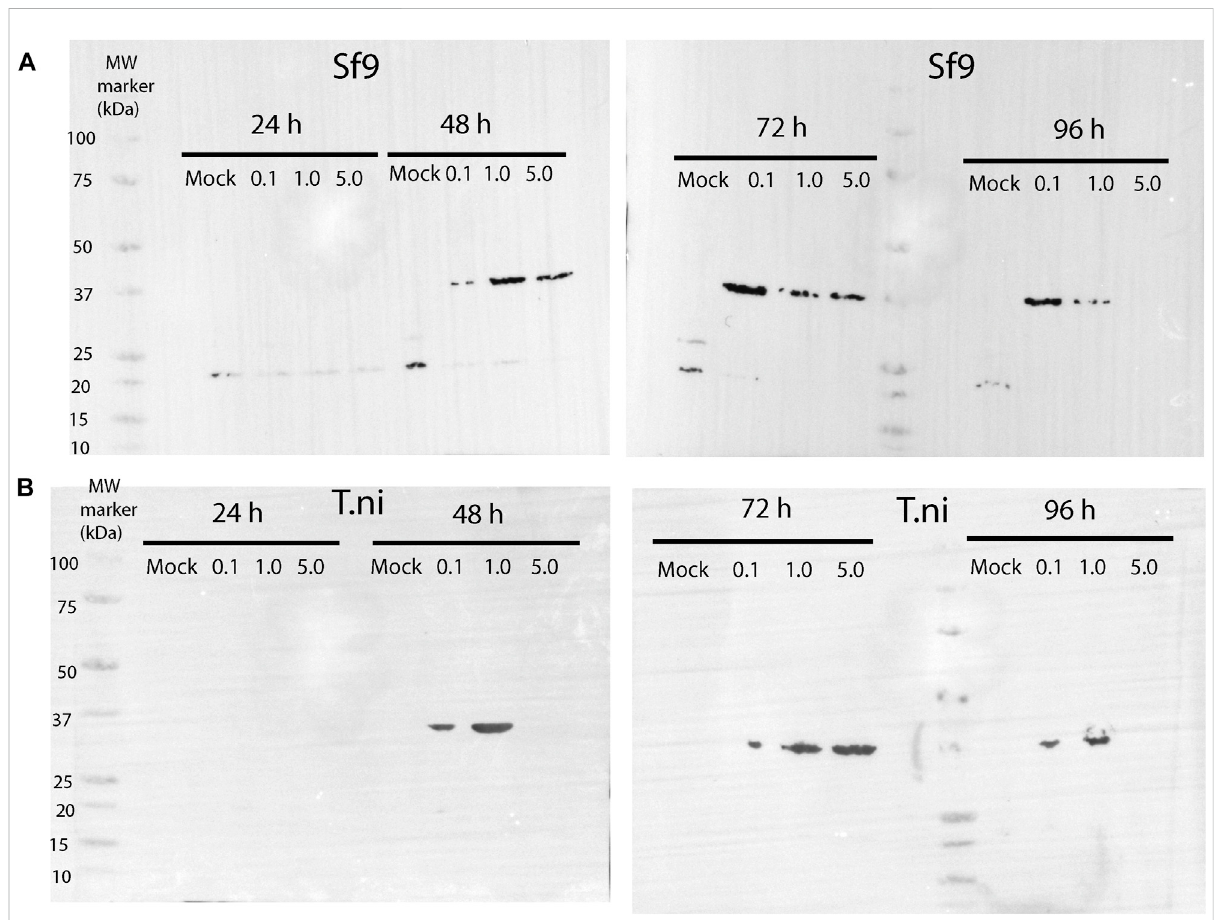
FIGURE 2 Western blot showing the time-course expression of AtCDC20.1 WD40 in Sf9 (A) and T.ni (B) cells. In each case, three different MOIs, 0.1, 1.0, and 5.0, were tested. Non-infected cells (e.g., mock) were used as a